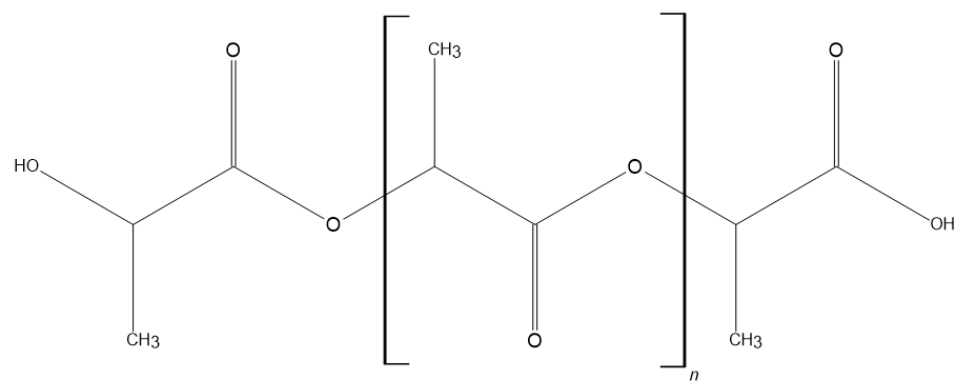
Figure 3. Polylactide